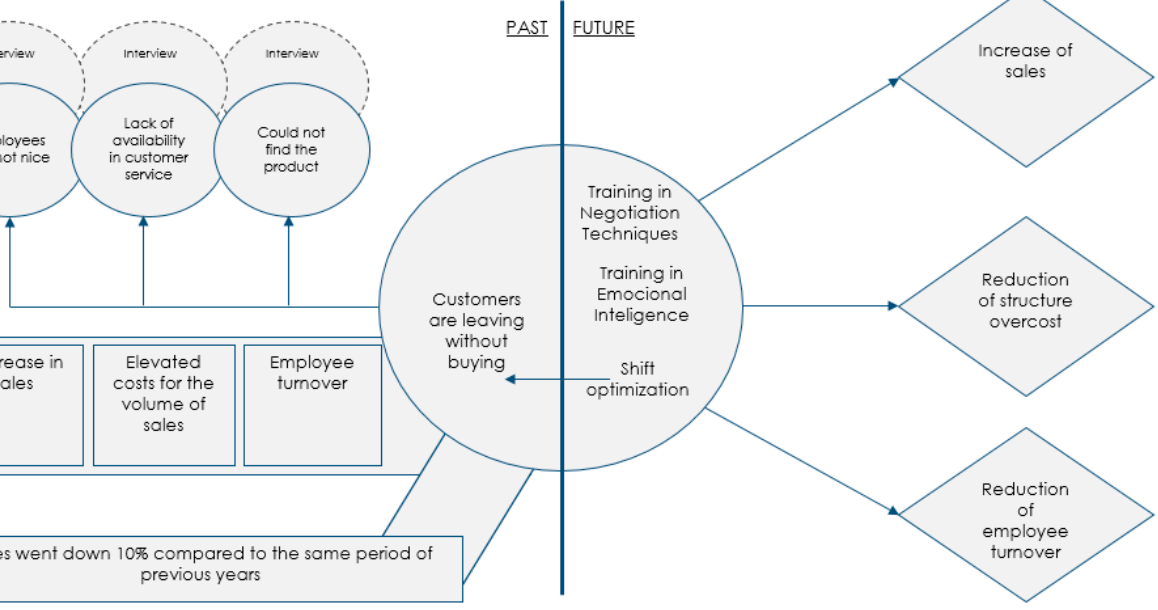
Figure 12. Example of Pereira Problem-Solving Diagram (authors).